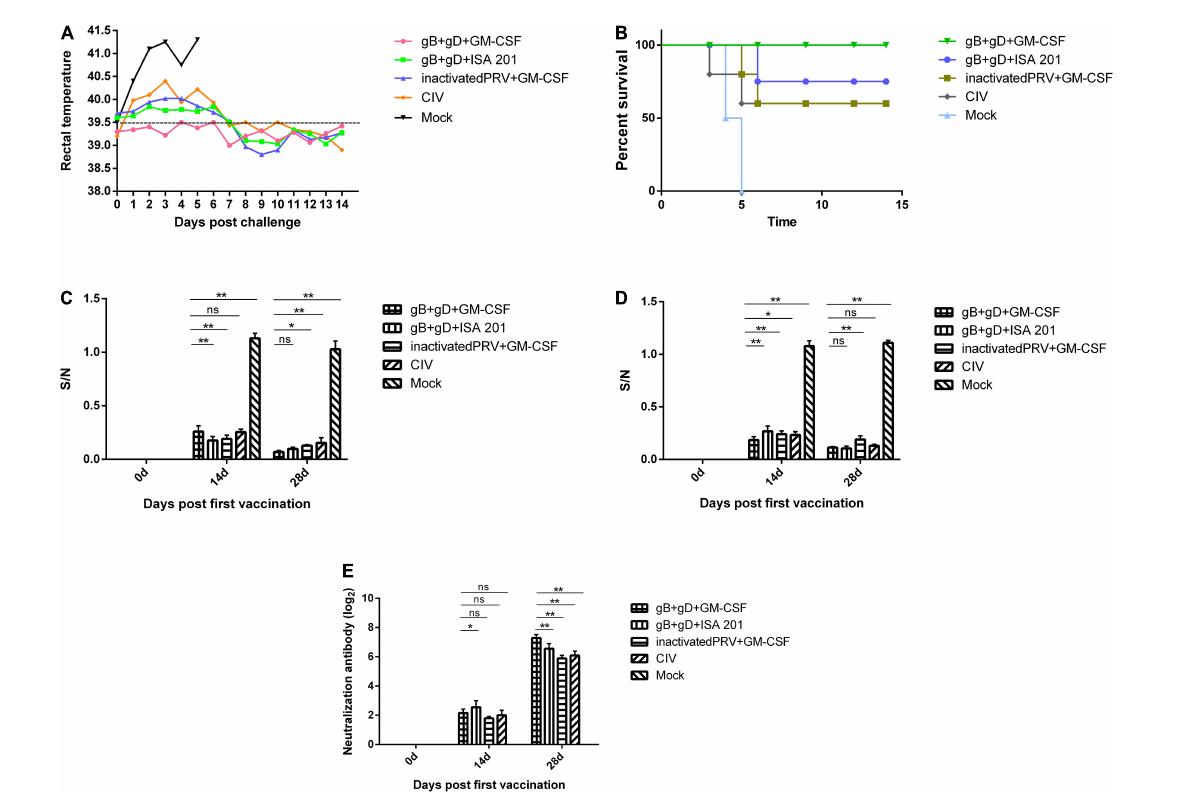
FIGURE4 Protection against challenge with the PRV SD-2017 strain in rabbits. Rabbits of three groups were inoculated with gB + gD + GM-CSF (each 100 µ g with 200 µ g GM-CSF), gB + gD + ISA 201 (each 100 µ g with 200 µ g of ISA 201), or inactivated PRV + GM-CSF (1 mL of inactivated PRV with 1 mL of ISA 201). One group was vaccinated by commercial inactivated vaccine (CIV) and another group was not injected and served as a mock group. All rabbits were immunized at 0 and 14 days and challenged at 28th day with 5 LD 50 of the PRV SD-2017 strain. Blood was collected on the 14th and 28th days. Rectal temperature (A) was measured during the 14-day observation period, and mortality (B) was recorded. gB-specific antibody (C) , gD-specific antibody (D) and NA titers (E) in serum were measured at 14th and 28th days. Data were analyzed by two-way ANOVA using GraphPad Prism software. Significance is presented as * p < 0.05, ** p < 0.01. Error bars represent SD .